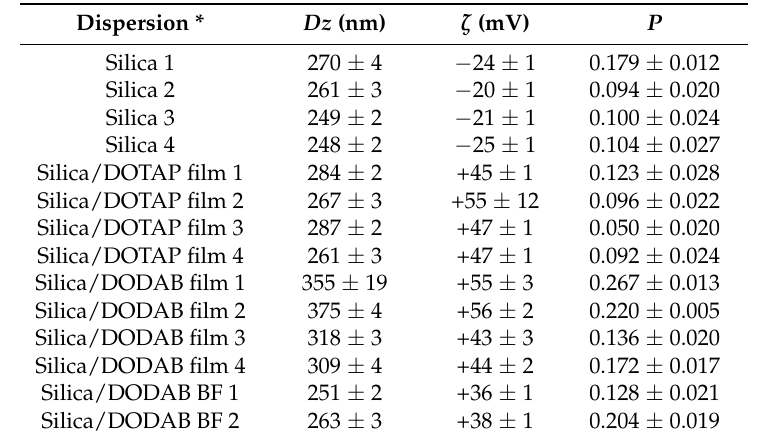
Table 1. Sizes, zeta potentials and polydispersities for equivalent but different dispersions (numbered from 1 to